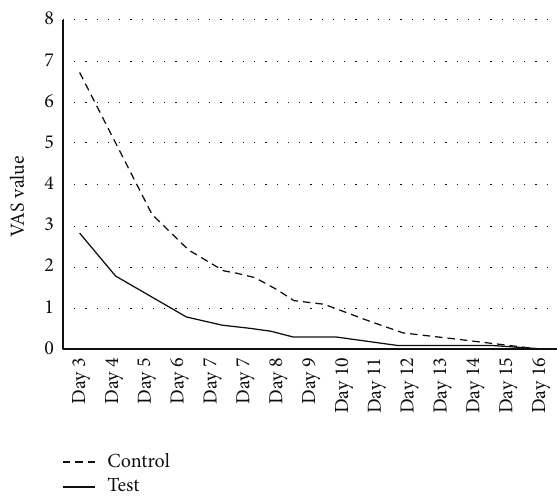
Figure 4: Discomfort at brushing (VAS scales: 0 = minimum, 10 = maximum) during the study period for test (TB1) and control (TB2)